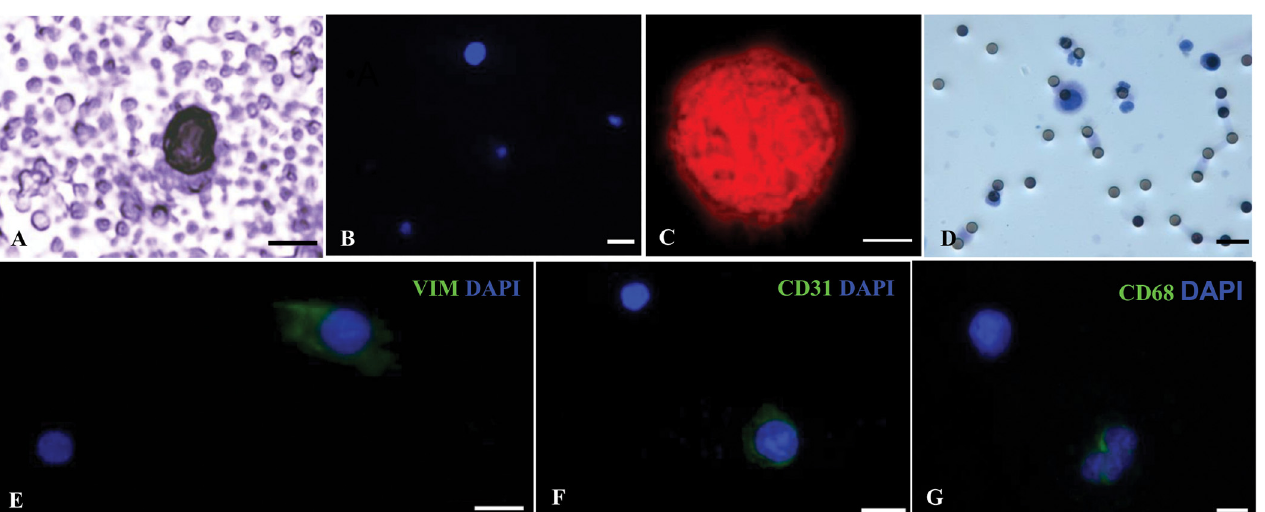
Fig 5. Morphologic and immunophenotypic characteristics of suspicious circulating elements in healthy donors. Representative image of a hematoxylin stained nucleus isolated by depletion procedure (A). A DAPI stained nucleus isolated by depletion procedure and small contaminant white blood cells (B). Confocal image of a propidium iodide (PI) stained nucleus obtained by depletion procedure (C) and a hematoxylin and eosin stained nucleus isolated by the ScreenCell device (D). E — G: cytospin preparations obtained after depletion procedure and tested by immunocytochemistry showing a vimentin positive cell associated with a negative leukocyte (E), a CD31 immunostained cell with a negative leukocyte (F) and two CD68 positive and one CD68 negative cells (G). Scale bars: A, E, F, G = 10 μ m; B, D = 20 μ m; C = 5 μ m.